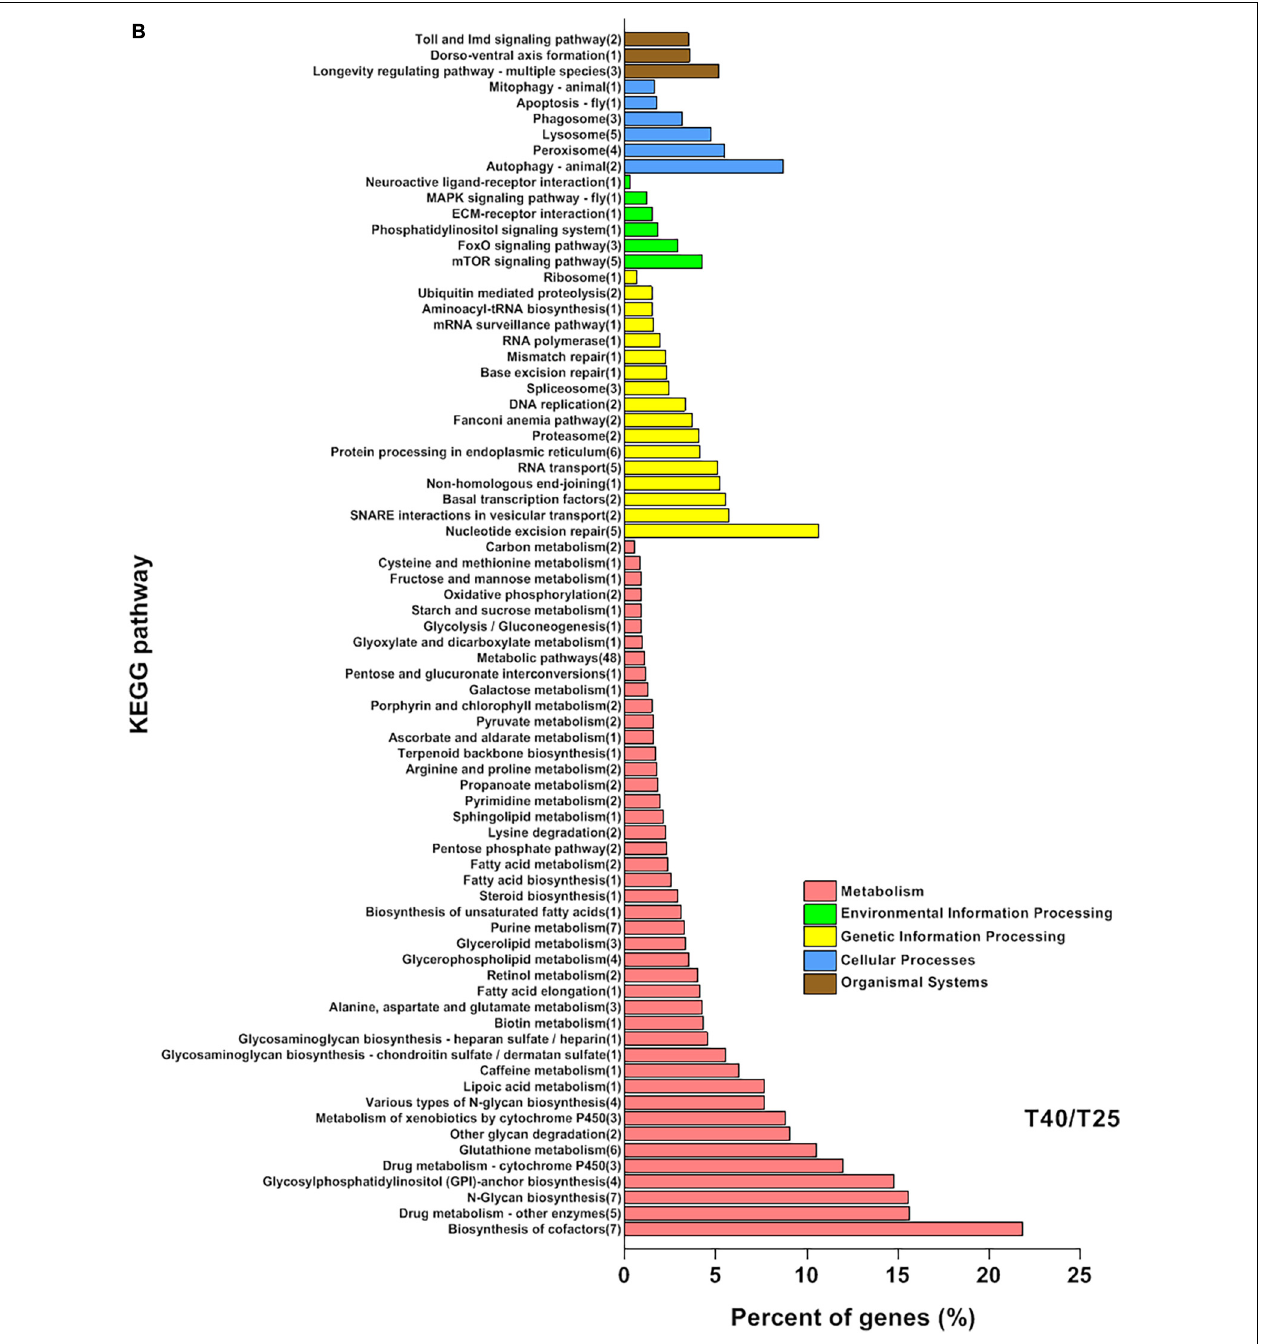
FIGURE 5 | Kyoto Encyclopedia of Genes and Genomes pathways enrichment analysis. Analysis of significant KEGG pathways enrichment in the specific differentially expressed genes (DEGs) ( P -value < 0.01, log 2 FC ≥ 5, ≤ –5) coregulated by cold (A) and high (B) temperature stresses in comparison with T25 as control group. The Y -axis indicates the KEGG pathways, and the X -axis indicates the percentage of unigenes in each pathway, indicated on the left side of bars. The numbers in the brackets are DEGs significantly enriched in the relevant